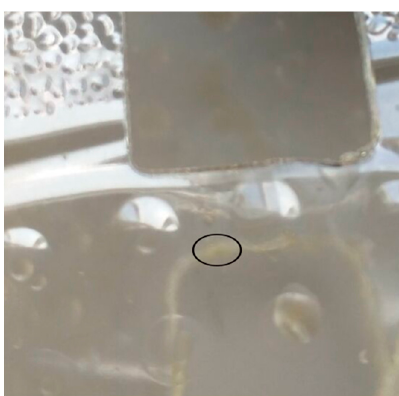
Figure 7. Heat-affected zone (HAZ) area of the laser cut material. Figure 7. Heat-a ff ected zone (HAZ) area of the laser cut